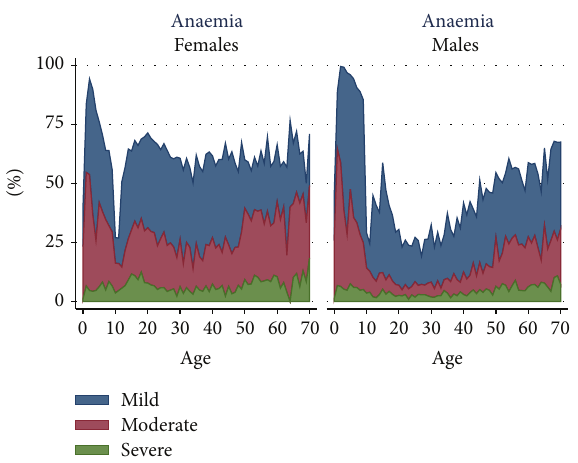
Figure 3: Prevalence of mild, moderate, and severe anaemia by age in males and